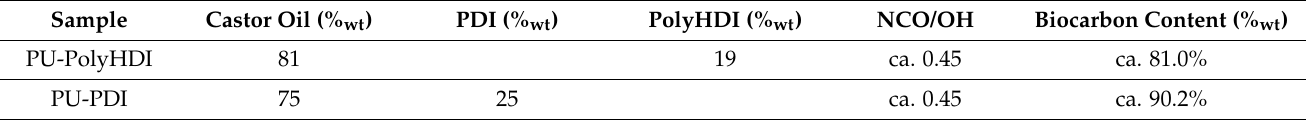
Table 1. Ratios of the components of the two different castor oil derived